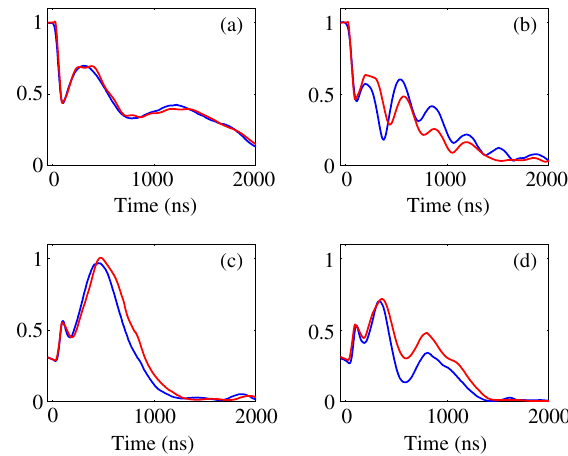
FIG. 11. Comparison of simulation (red line) and experimental results (blue line) of single-breakdown event (left) and multiple- breakdown event (right). (a),(b) Normalized pickup signal. (c), (d) Normalized reflection